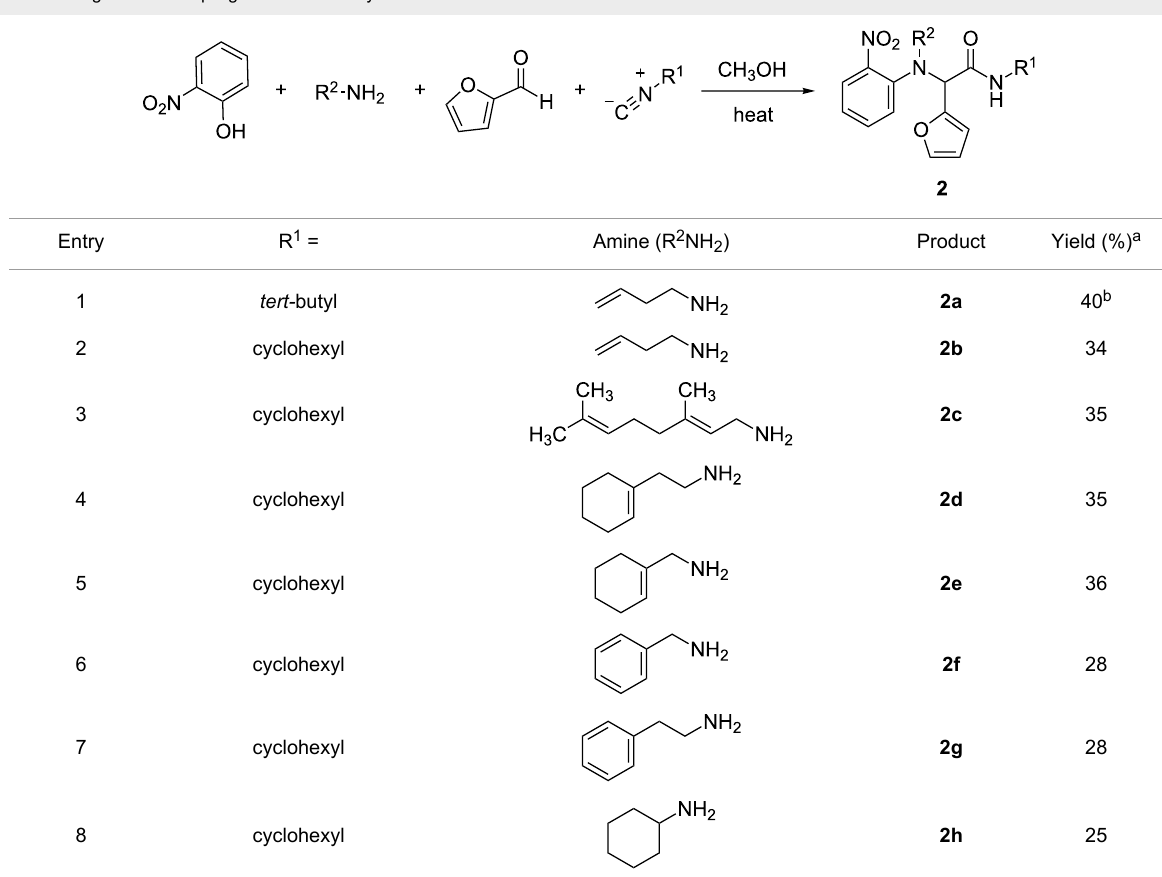
Table 2: Ugi–Smiles couplings with